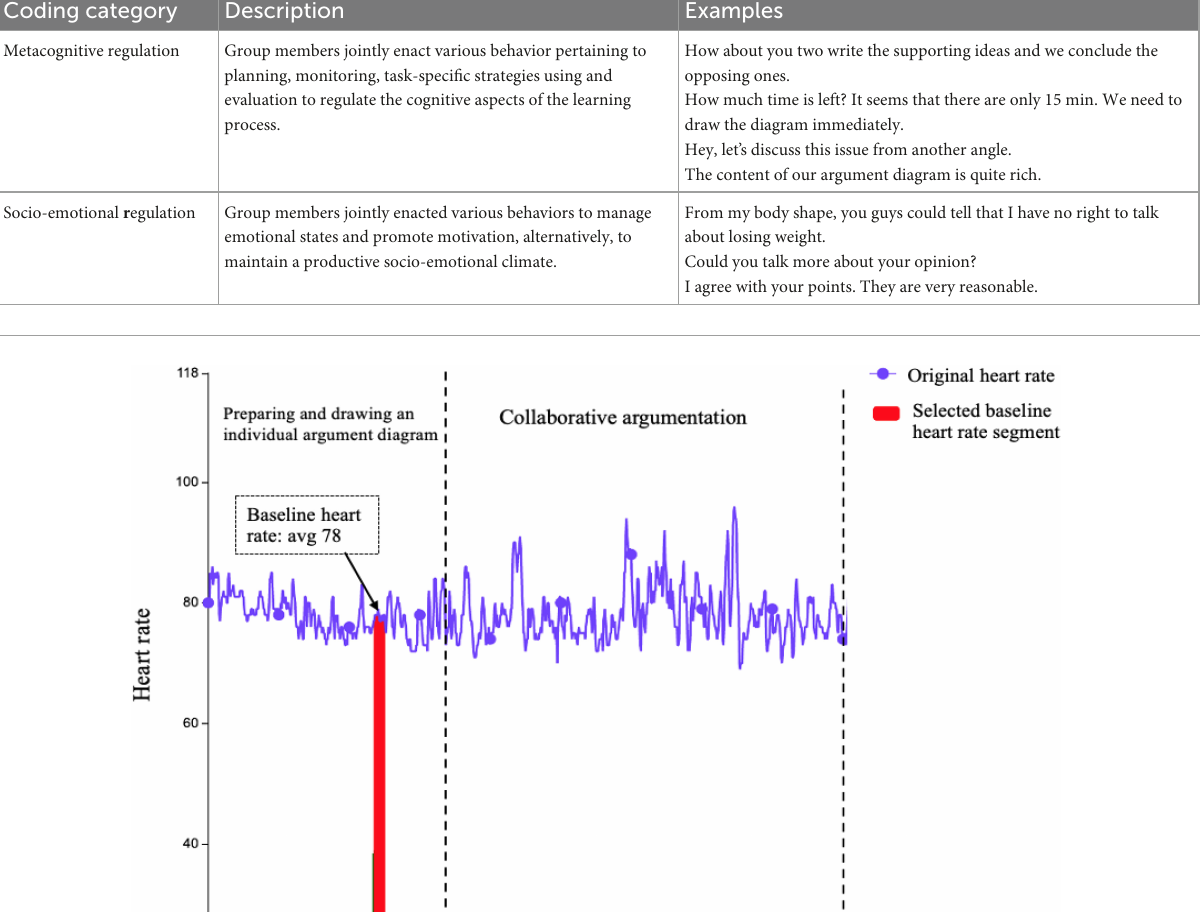
TABLE 2 Coding scheme for social regulation. Coding category